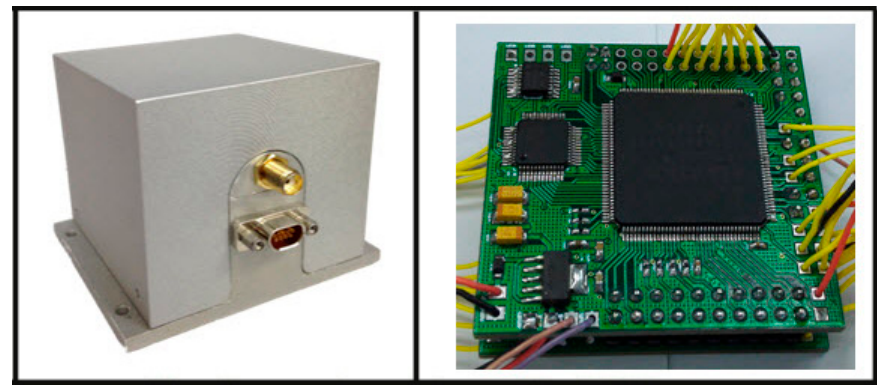
Figure 6. Homemade prototype of the AHRS. Homemade prototype of the AHRS ( Left ) and its circuit component ( Right ).